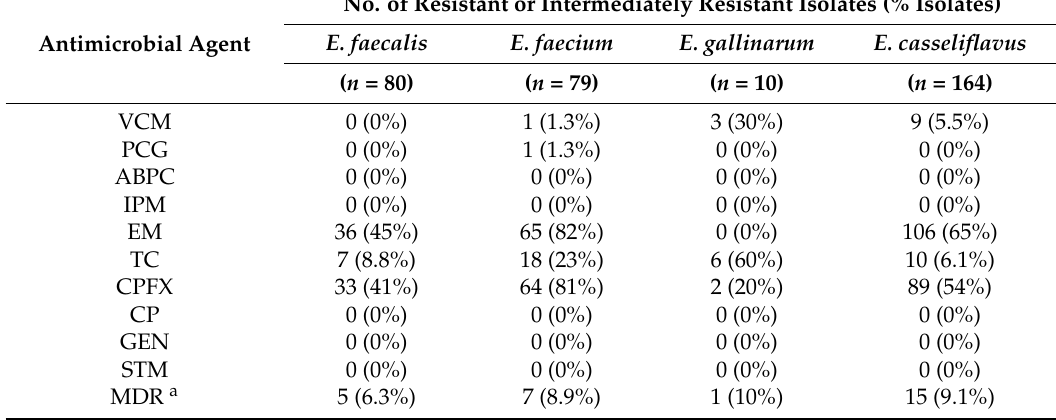
Table 3. Antibiotic resistance of 333 Enterococcus spp. from Yae River.